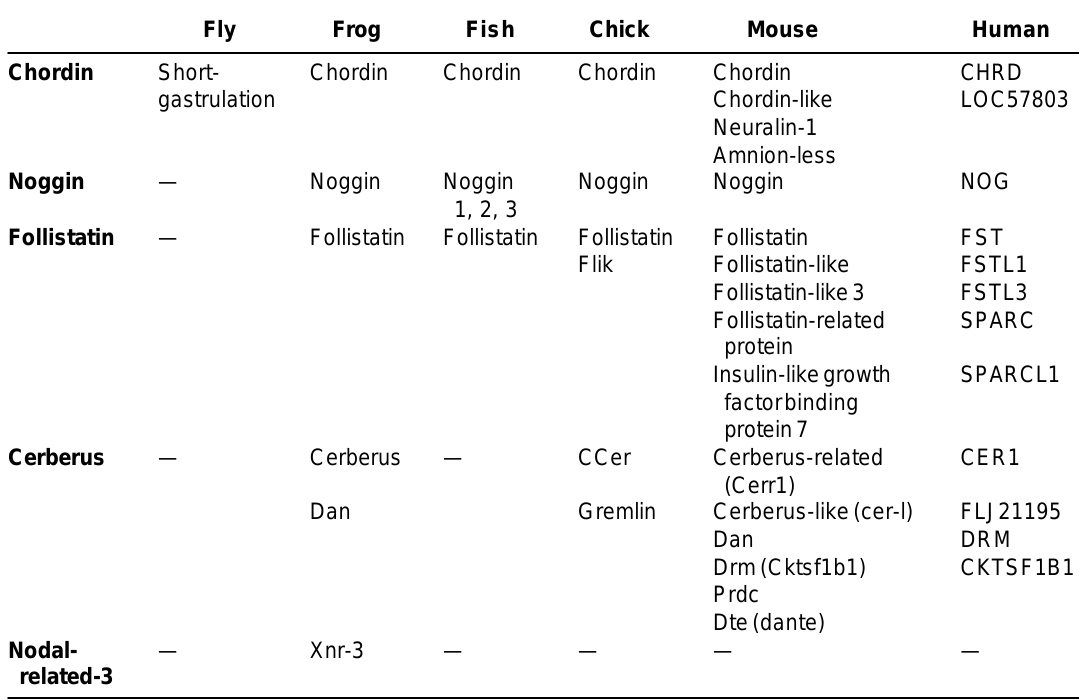
Names of Neural-Inducing, Anti-BMP Molecules Across